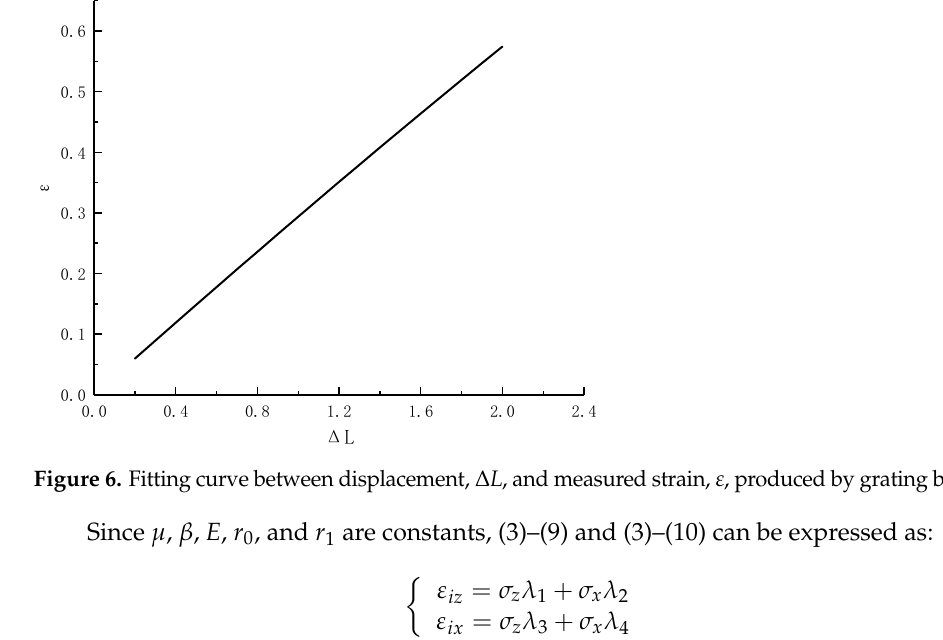
was linearly related to the stress of surrounding